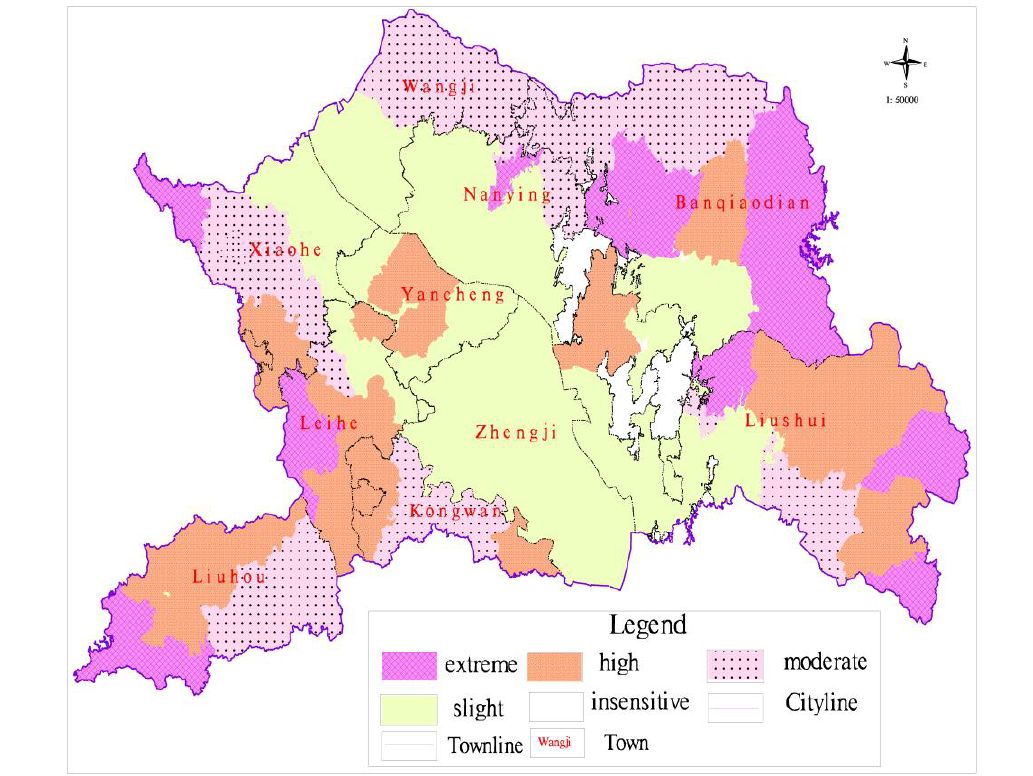
Figure 4. Grade map of synthetic eco-environment sensitivity in Yicheng City.